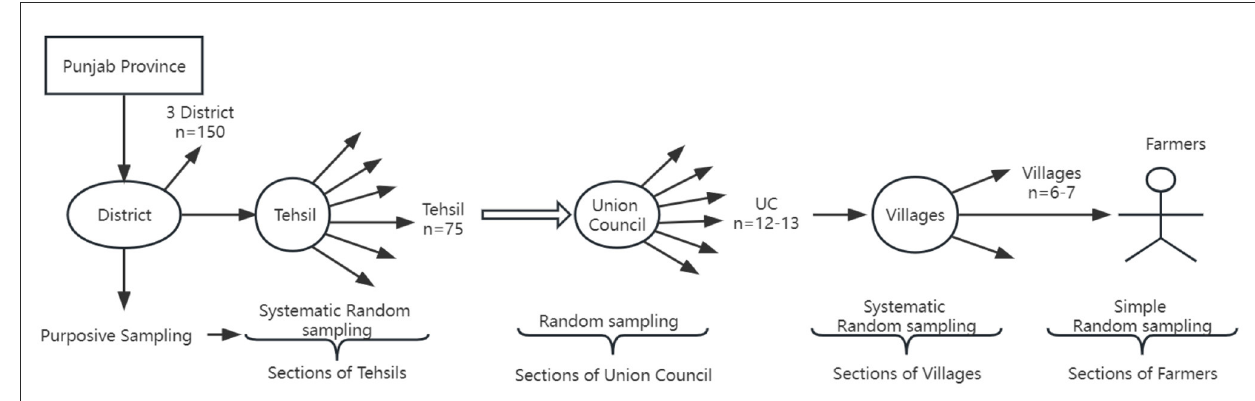
FIGURE2 Sampling framework showing number of smallholders farmers each districts, tehsil and union council.